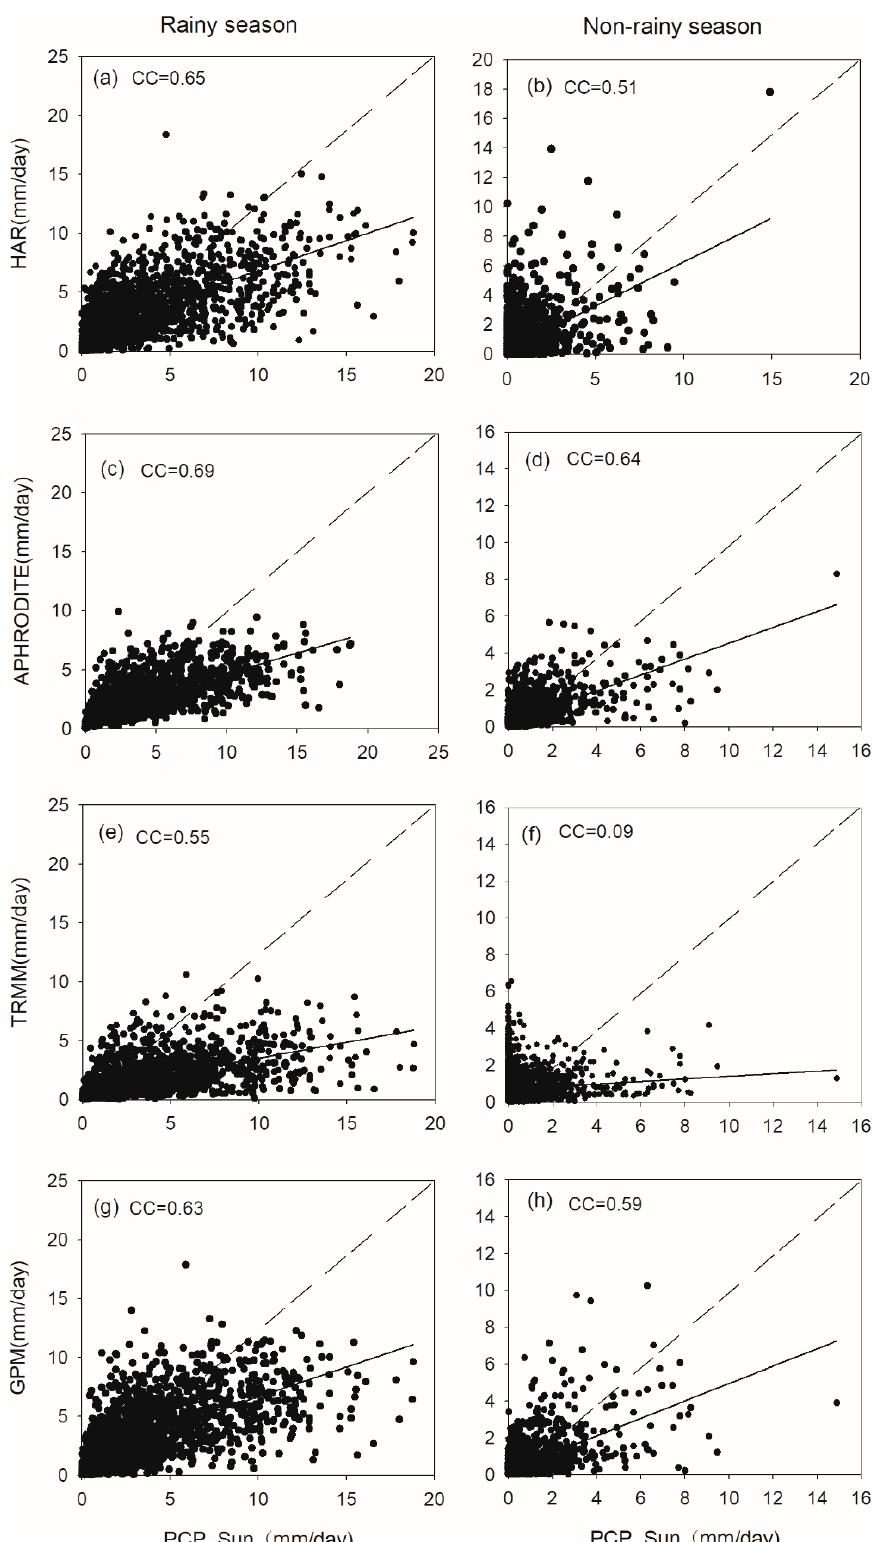
Figure 5. Scatterplots of daily basin-wide precipitation between gridded precipitation and reference precipitation during rainy season (( a ) HAR, ( c ) APHRODITE, ( e ) TRMM, ( g ) GPM), and non-rainy season (( b ) HAR, ( d ) APHRODITE, ( f ) TRMM, ( h ) GPM). The solid line shows the linear least-squares result, and the diagonal dash line shows the 1:1 line.